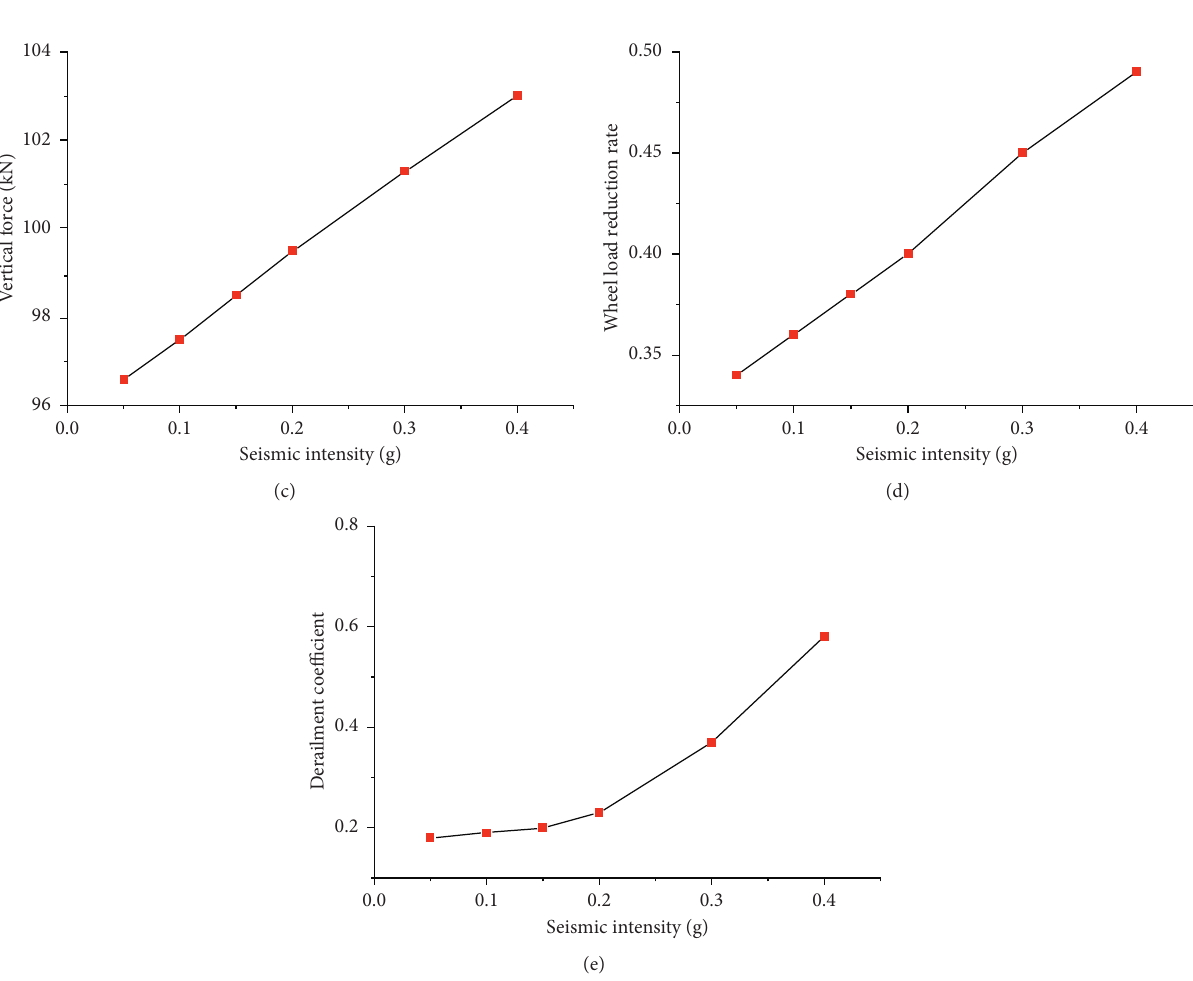
Figure 22: Changes in the dynamic response indexes under the El Centro wave. (a) Changes in lateral acceleration. (b) Changes in lateral force. (c) Changes in vertical force. (d) Changes in wheel load reduction rate. (e) Changes in derailment